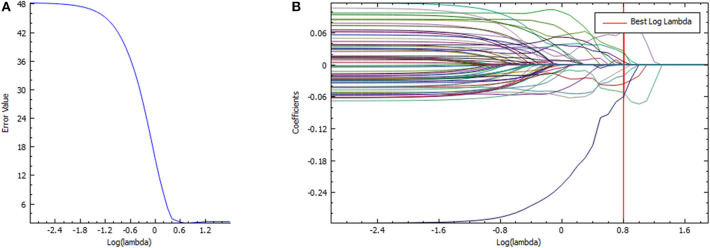
Feature selection in the LASSO model. (A) LASSO error graph tuning parameter (λ) selection in the LASSO model used 10-fold cross-validation via minimum criteria. The error value was plotted vs. log(λ). Seven features with the smallest error value were selected. (B) LASSO coefficient profiles of the texture features. The red vertical line is drawn at the value selected using 10-fold cross-validation in log(λ) sequence and coefficients with non-zero values are indicated.